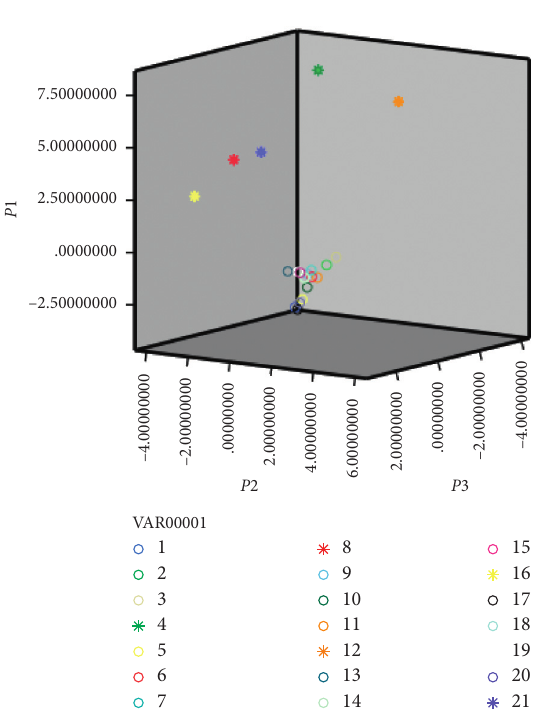
Figure 5: Scatter plot of principal